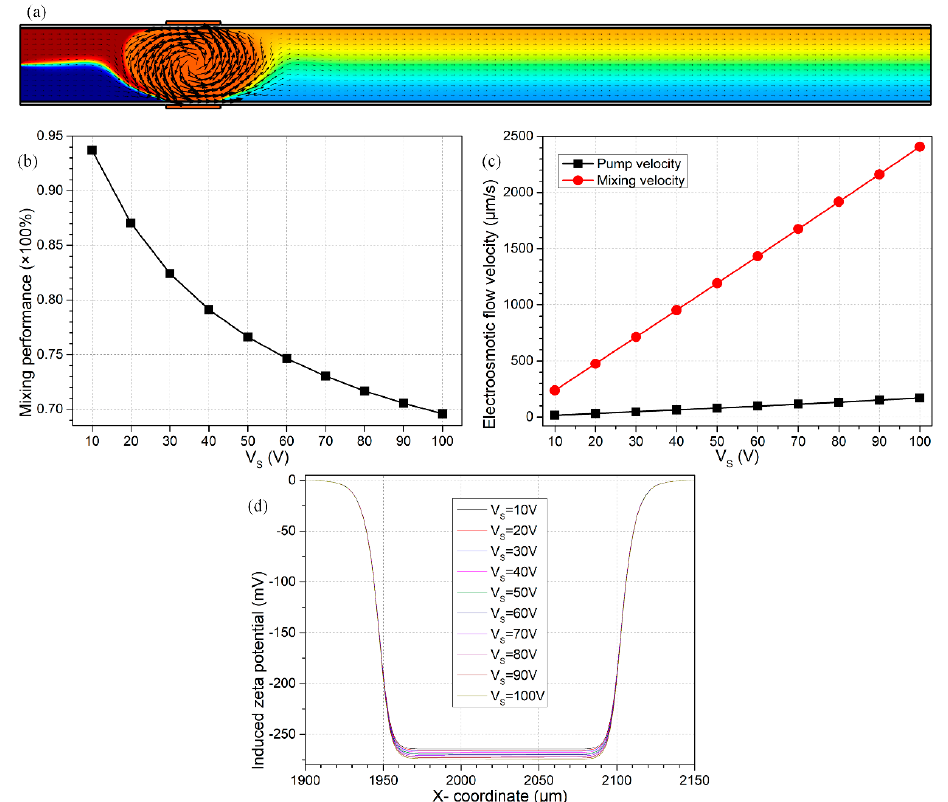
Figure 4. Effect of source voltage magnitude Vs on the efficiency of device bifunctionality, for given values of V G = 2000 V and L G = 150 μm. ( a ) An arrow and surface plot of the electroosmotic flow field and resulting analyte mass distribution (unit: mol/m 3 ) under Vs = 70 V with γ = 73.03%. ( b ) Vs-dependent device mixing performance. ( c ) Characteristic pumping and mixing flow velocity of electroosmosis as a function of the source voltage Vs. ( d ) Distribution of inhomogeneous induced zeta potential at the sidewall/medium interface next to the negatively-polarized G terminal for varying Vs; the minus sign means positive charge cloud is induced inside the diffuse double layer above the right-side G terminal.